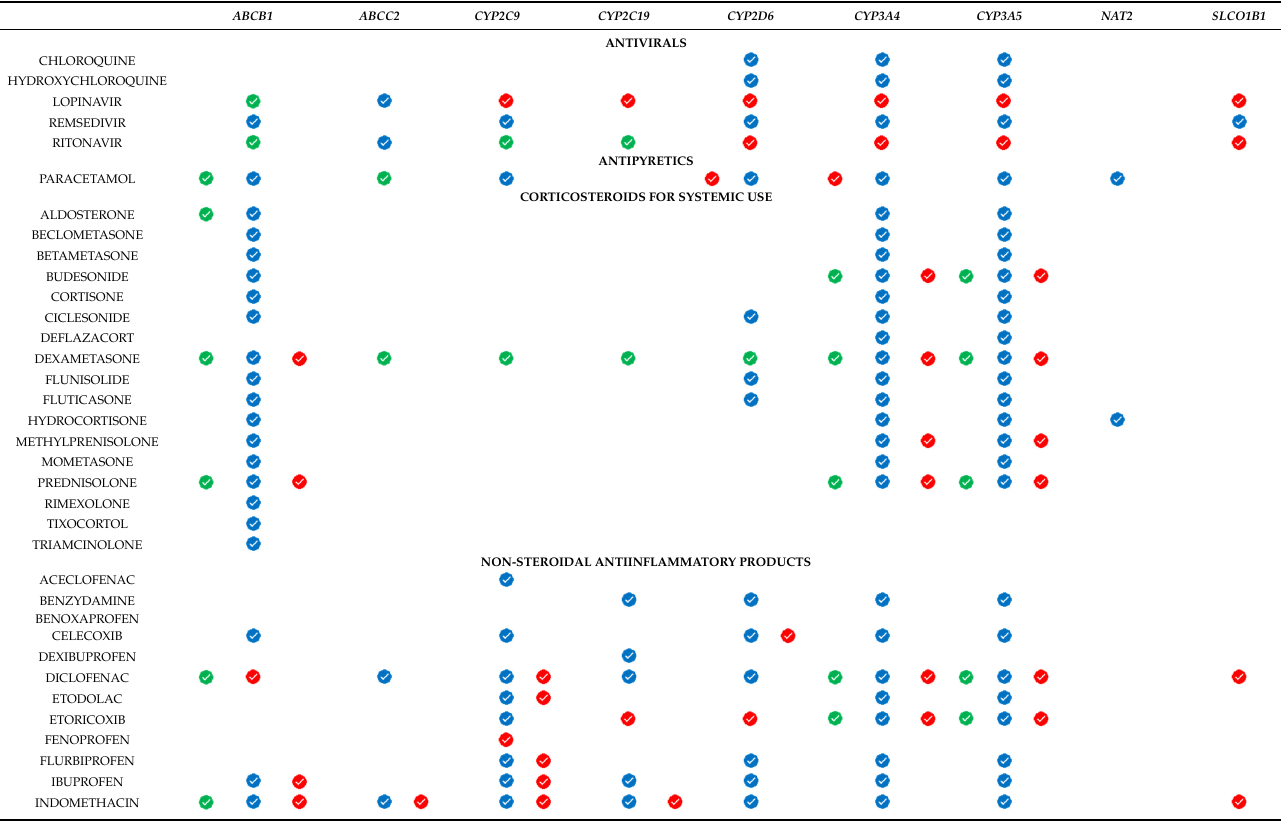
Table 4. COVID-19 pharmacogenetics.